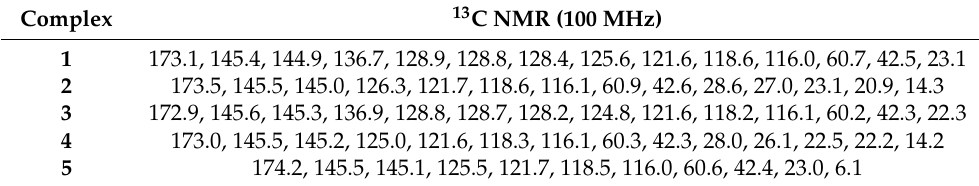
Table 4. 13 C NMR spectral data of 1–5